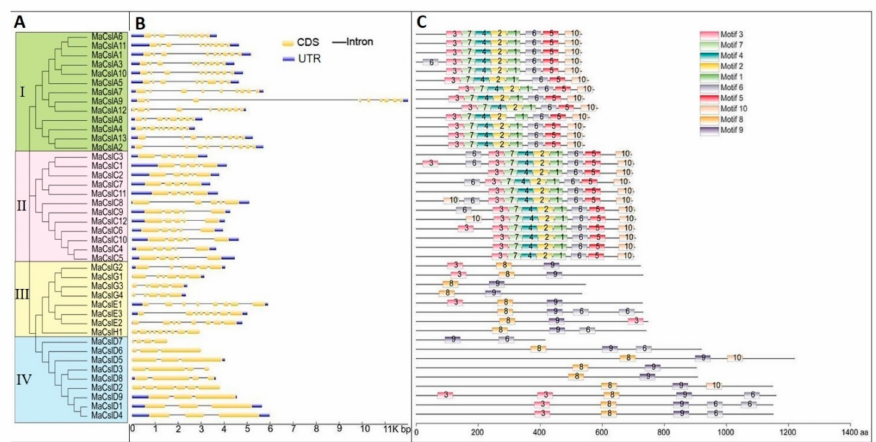
Figure 4. Phylogenetic relationships, gene structure, and motif distribution of MaCsls. ( A ) Unrooted phylogenetic tree of 42 MaCsls, generated with the MEGA7.0 software by the neighbor-joining method with 1000 bootstrap replicates after alignment of the full-length protein sequence by Clustal W. ( B ) Exon/intron structures of MaCsl genes. ( C ) Conserved motifs of the MaCsl gene family, analyzed by Multiple Em for Motif Elucidation (MEME). Different motifs are represented by different colored boxes with numbers 1–10 (color figure